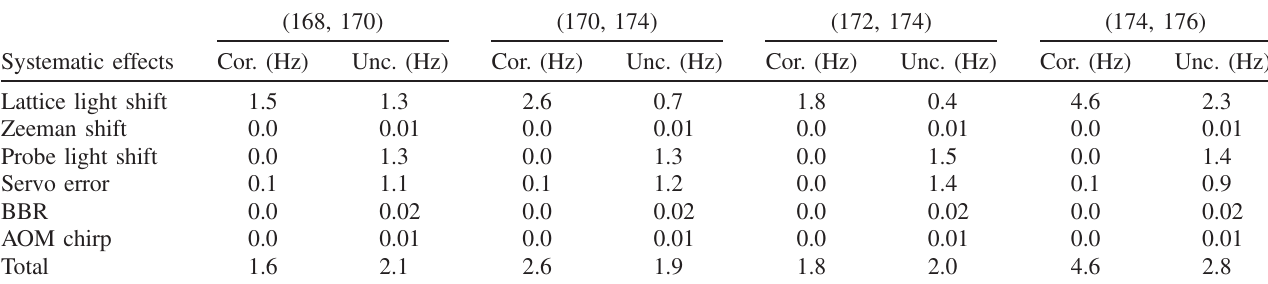
TABLE I. Systematic corrections and uncertainties for measurements of ISs.